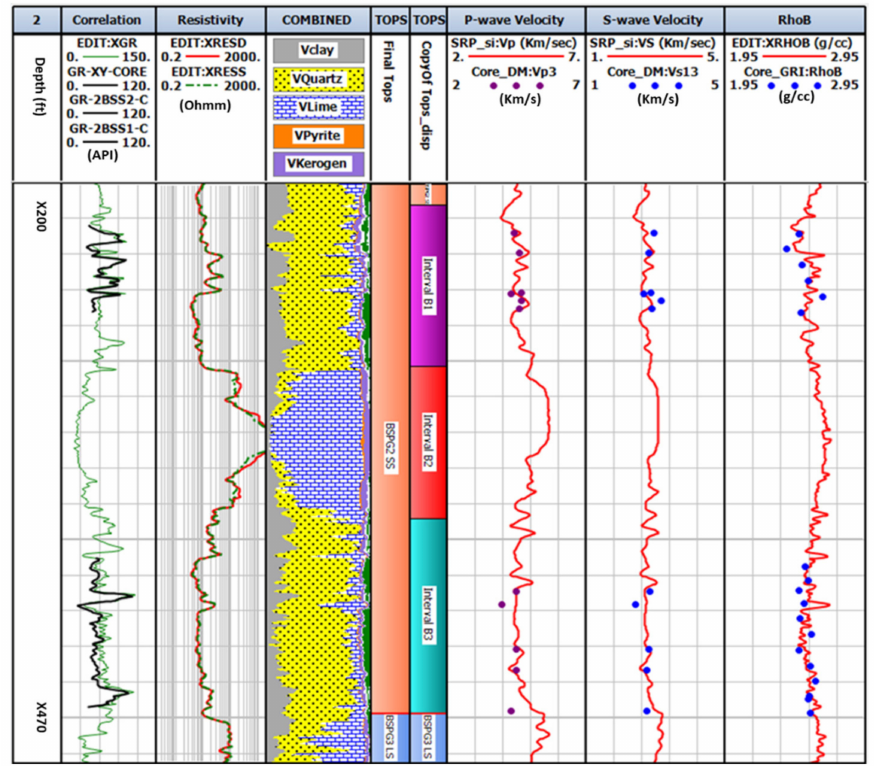
Figure 11. Log plot of the Bonespring formation. The Correlation track contains Gamma-ray (green curve) and core gamma ray (black curve). The Resistivity track contains resistivity log. The COM- BINED track contains formation lithology fractional volumes determined by volumetric log analyses. The P-wave velocity track contains sonic P-wave velocity (red curve) and ultrasonic P-wave velocity (purple discrete data points). The S-wave velocity track contains sonic S-wave velocity (red curve) and ultrasonic S-wave velocity (blue discrete data points). The RhoB track contains log measured bulk density (red curve) and core measured bulk density (blue discrete data). Depths in the depth track are only to indicate depth scale; actual depths are not available for